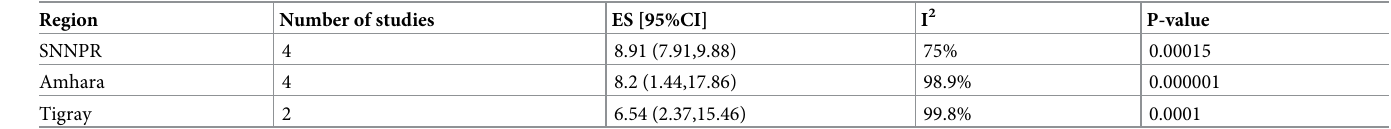
Table 2. Subgroup analysis on maternal mortality of uterine rupture by region in Ethiopia. Region